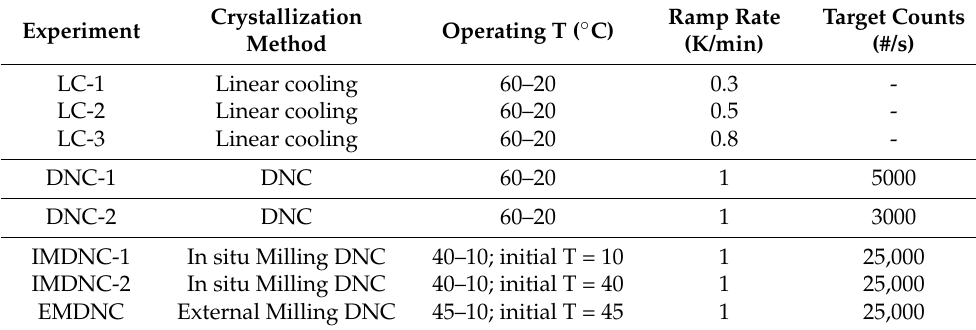
Table 1. Process conditions for the crystallization